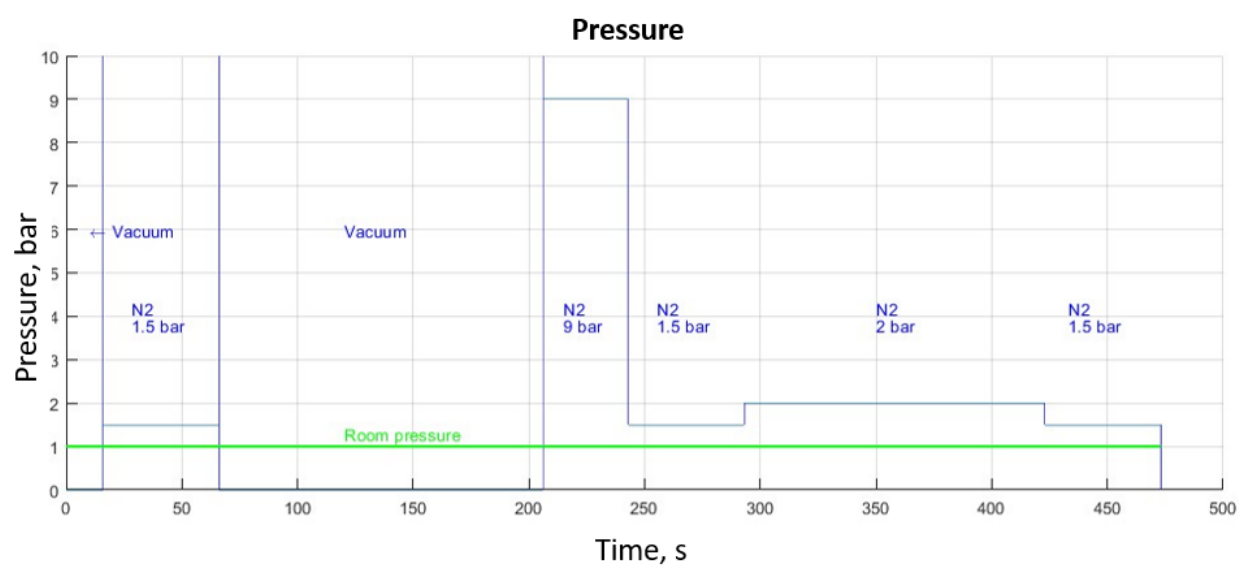
Figure 4. Extended heat and pressure diagrams generated in MATLAB.